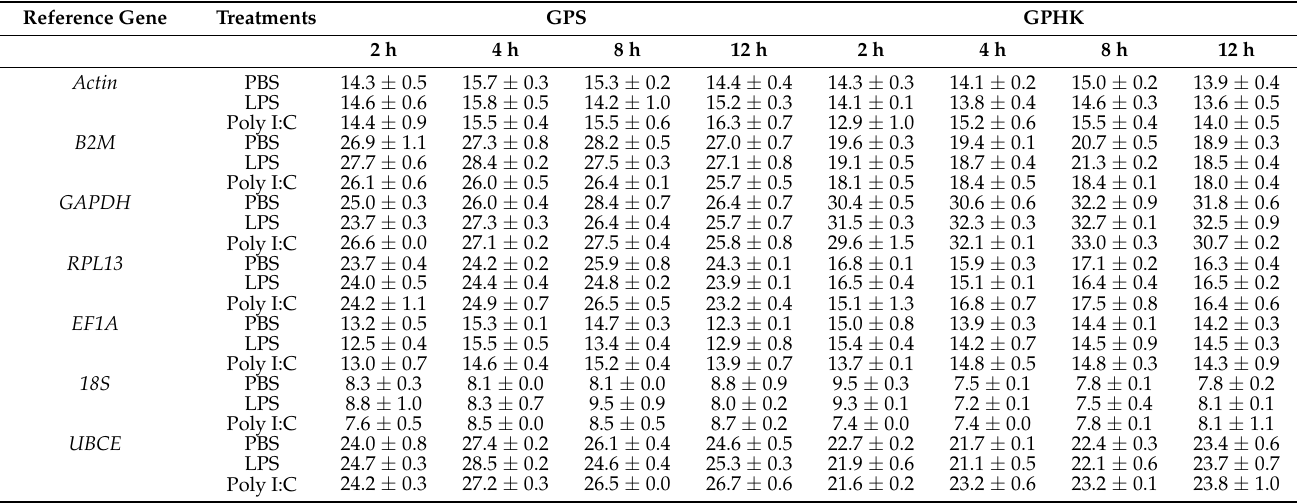
Table 3. Expression abundance of seven housekeeping genes among GPS and GPHK cells under stimulation of LPS or Poly I:C for 2, 4, 8 and 12 h. Values are shown as means ± SD ( n =